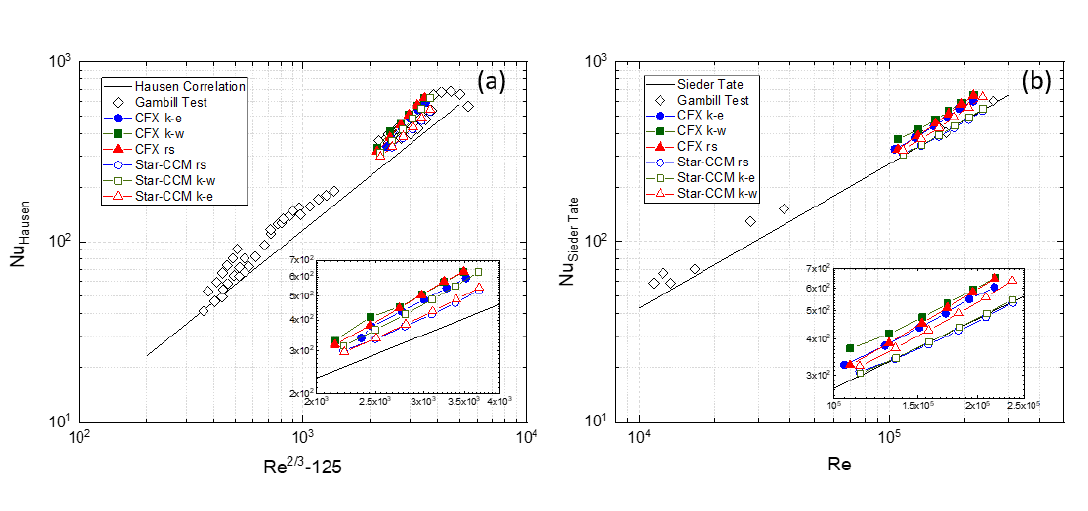
Figure 8: The results for the Hausen (a) and Sieder Tate (b) equations by using mesh 1a in Ansys CFX and mesh 1b in STAR-CCM+ are shown. A roughness of 1 . 6 µ m is used.